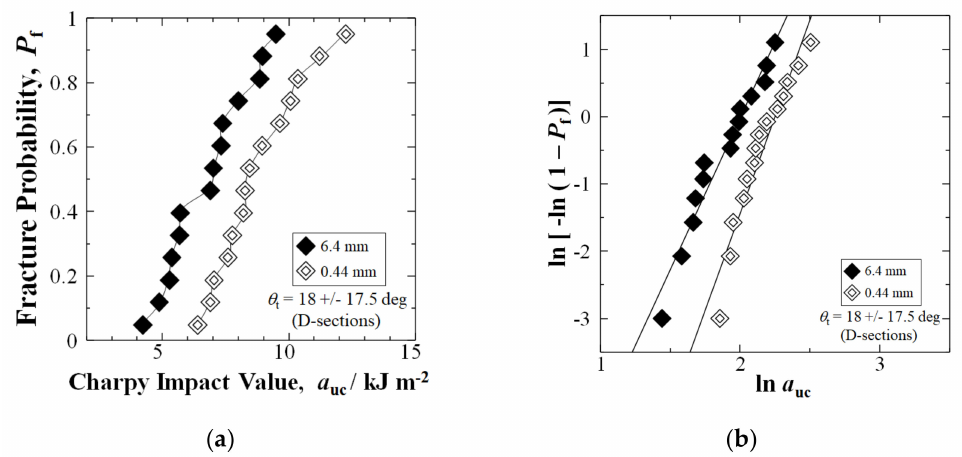
Figure 9. ( a ) Relationship between a uc and P f for nominal 6.4 mm and extended mixed 0.44 mm fiber sample, respectively, for D-Sections with θ t of 18 +/ − 17.5 deg between mold flow and longitudinal direction of testing sample; ( b ) Weibull 2-parameter plots of data in ( a